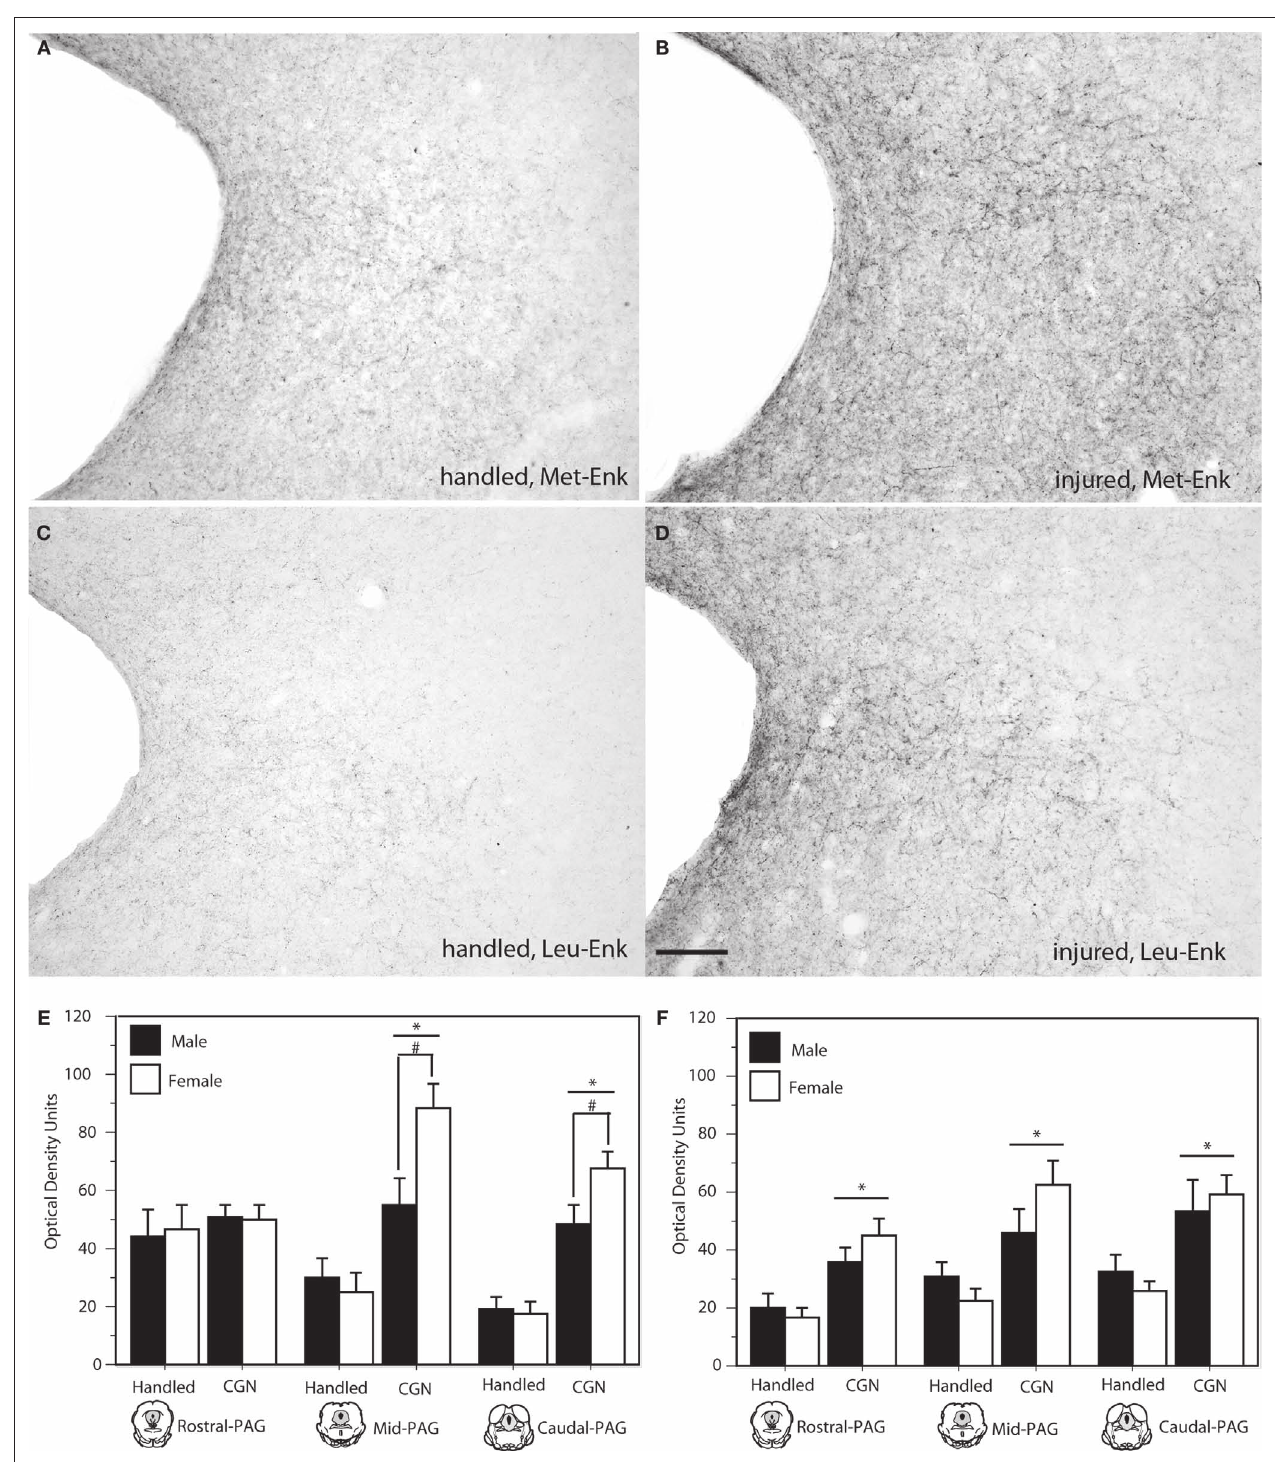
FIGURE 4 | Photomicrograph depicting met- and leu-enkephalin-ir at mid-level PAG in adult rats following neonatal handling (A,C) or intraplantar CGN (B,D). A signifi cant increase in met- and leu-enkephalin-ir (panels E and F , respectively) was noted in neonatally-injured animals compared to controls at all rostral-caudal levels of the PAG. N = 6–8 rats per group/per sex. * denotes signifi cant main effect of treatment; # denotes signifi cant main effect of sex. Error bars represent